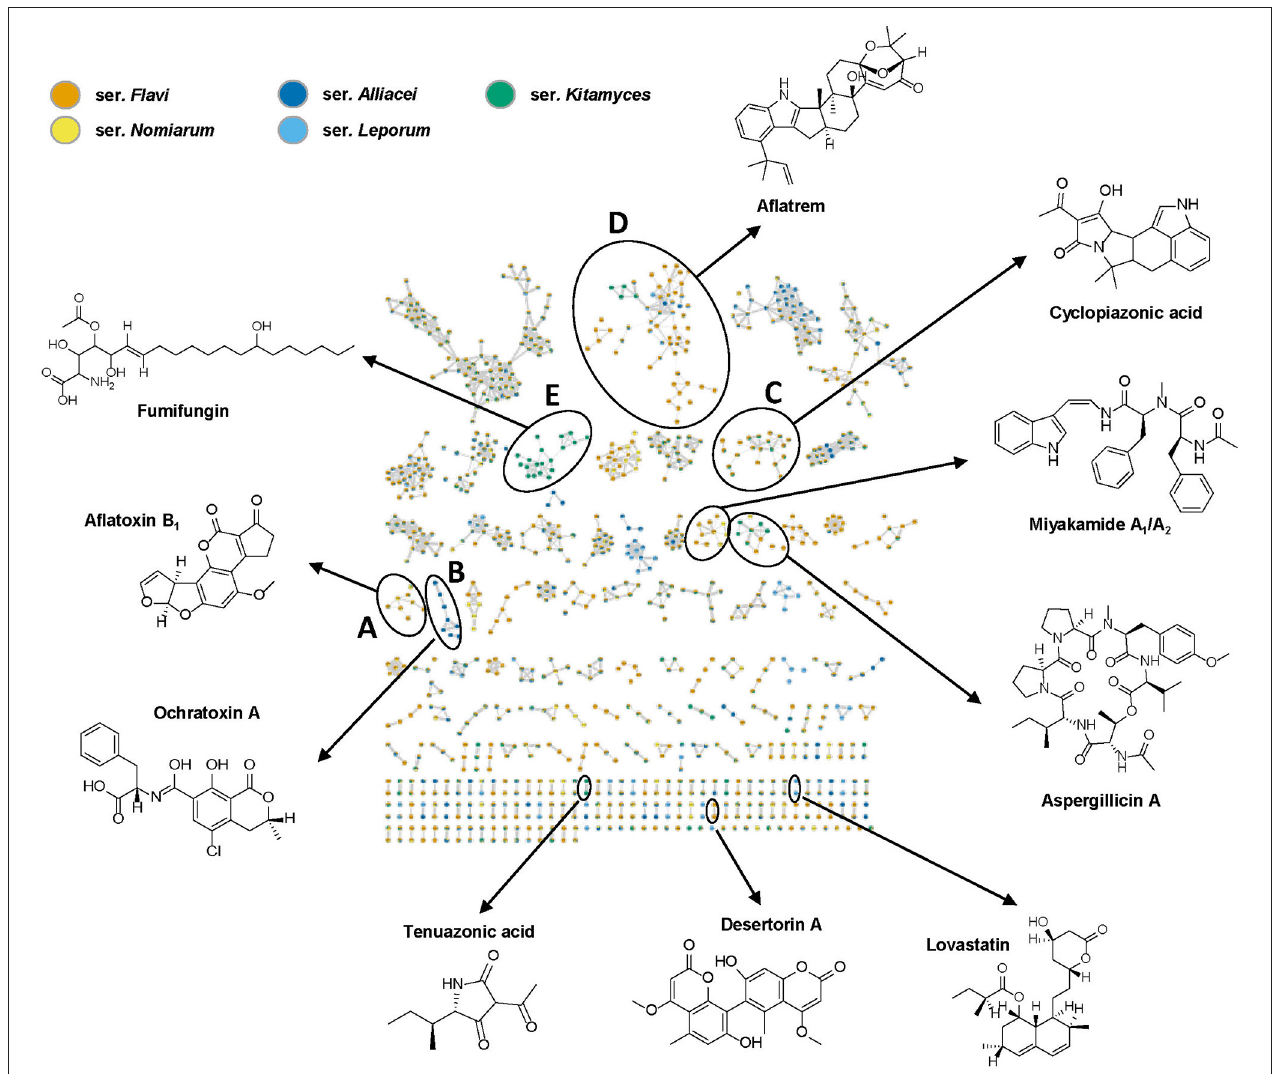
FIGURE 2 | Molecular network of all generated extracts and the standard compounds from the in-house database, including representative structures from 10 known types of compounds. The orange nodes represent ions detected from series Flavi ; green nodes represent ions detected from series Kitamyces ; yellow nodes represent ions detected from series Nomiarum ; blue nodes represent ions detected from series Alliacei , while light blue nodes represent ions detected from series Leporum . Color-assigned according to their series. Only clusters containing at least two nodes are shown. The detailed view for clusters A – E are presented in Figures 3 – 6